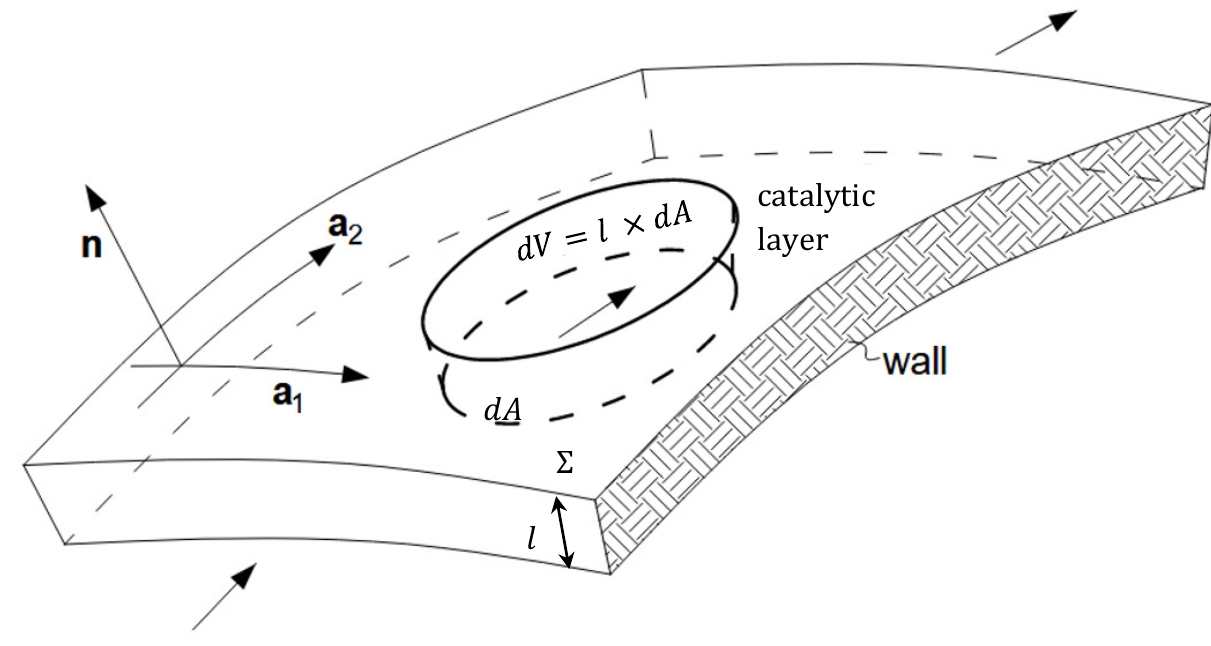
Figure 3. Scheme of a catalytic surface layer—the FSI framework.